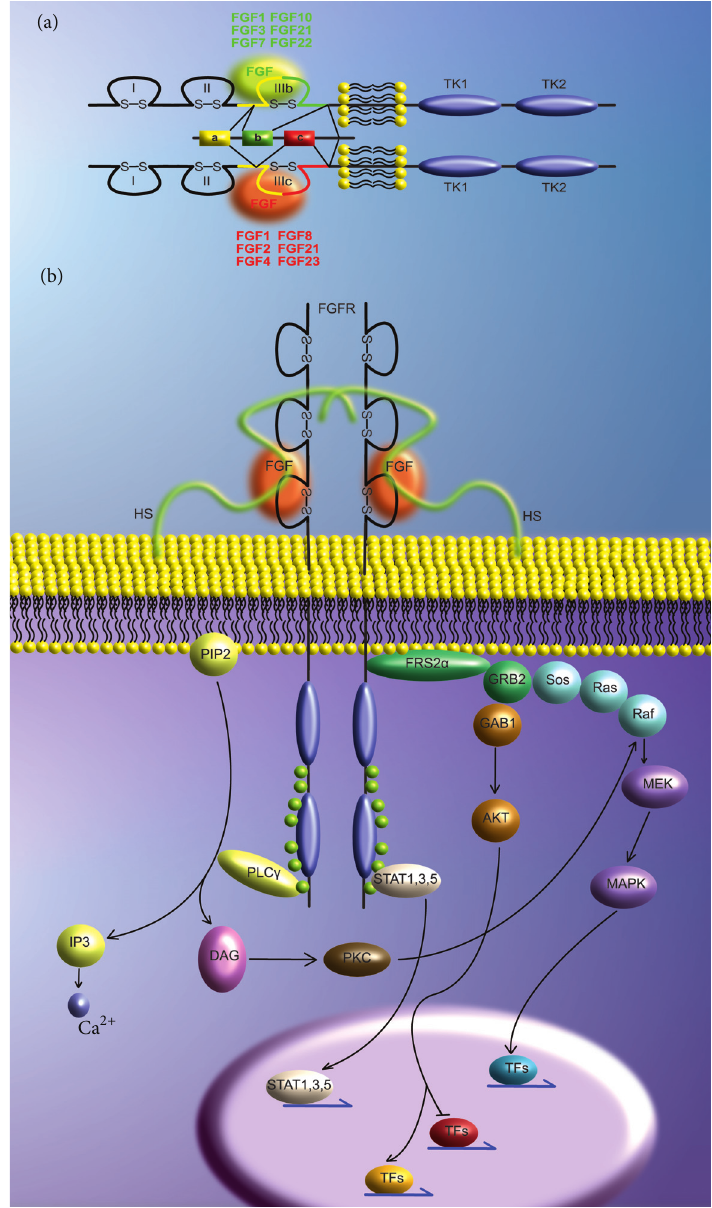
Figure 1: The FGFR signaling pathway. (a) Schematic of the structure of FGF receptors and the binding specificities of the FGF ligands. (b) Depiction of the FGFR downstream signalling. HS: heparan sulfate; PIP2: phosphatidylinositol 4,5-bisphosphate; IP3 inositoltriphosphate; PLC 𝛾 : phospholipase C; DAG: diacylglycerol; GRB2: growth factor receptor-bound protein 2; GAB1: GRB2 associated binding protein 1; Sos: son of sevenless; MEK: MAPK/ERK kinase; MAPK: mitogen activated protein kinase; STAT: signal transducer and activator of transcription; TFs: transcription